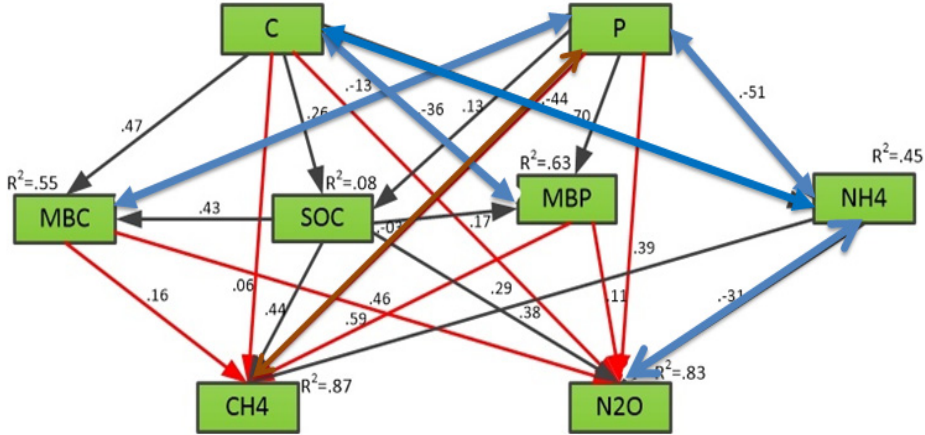
Figure 5. Structural equation model (SEM) showing direct and direct positive (red arrows), direct negative (brown double arrow), indirect and indirect positive (black arrows) and indirect negative (blue double arrows) effects of different soil parameters and greenhouse gases (GHG) under with and without glucose and phosphorus addition during incubation period.